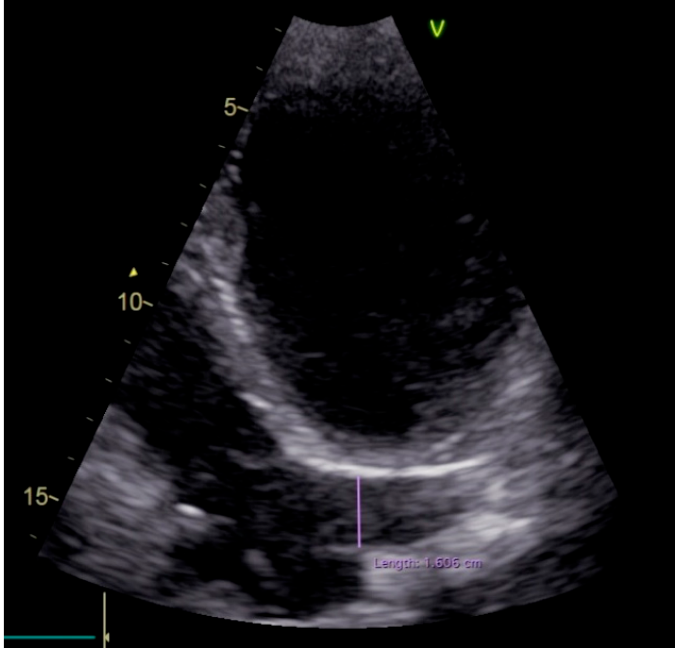
Figure 4. Two-dimensional echocardiography, apical four-chamber view showing a dilated CS (16 mm proximal).